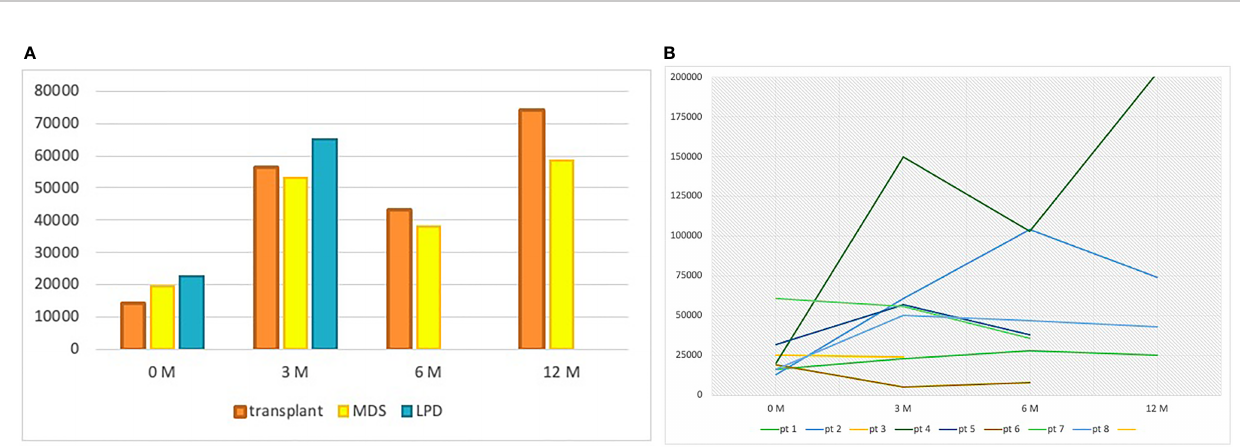
FIGURE 2 | (A) Median platelet count at baseline, 3, 6, and 12 months per group of patients. At 6 and 12 months, no data are reported for the lymphoproliferative patients because the median follow-up was inferior to 6 months in this group. LPD, lymphoproliferative disease; MDS, myelodysplastic syndrome; M, months. (B) Platelet counts over time for each MDS patient.